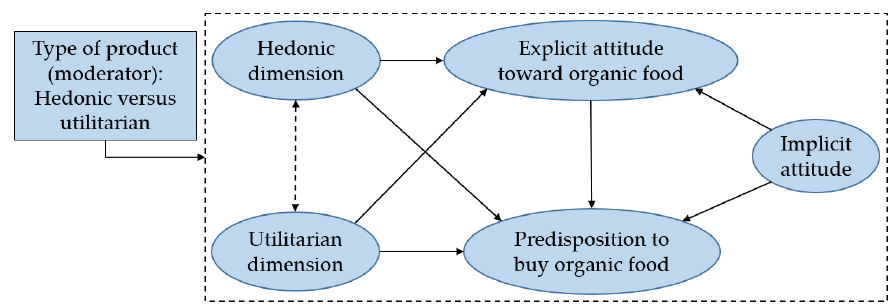
Figure 1. Conceptual model.